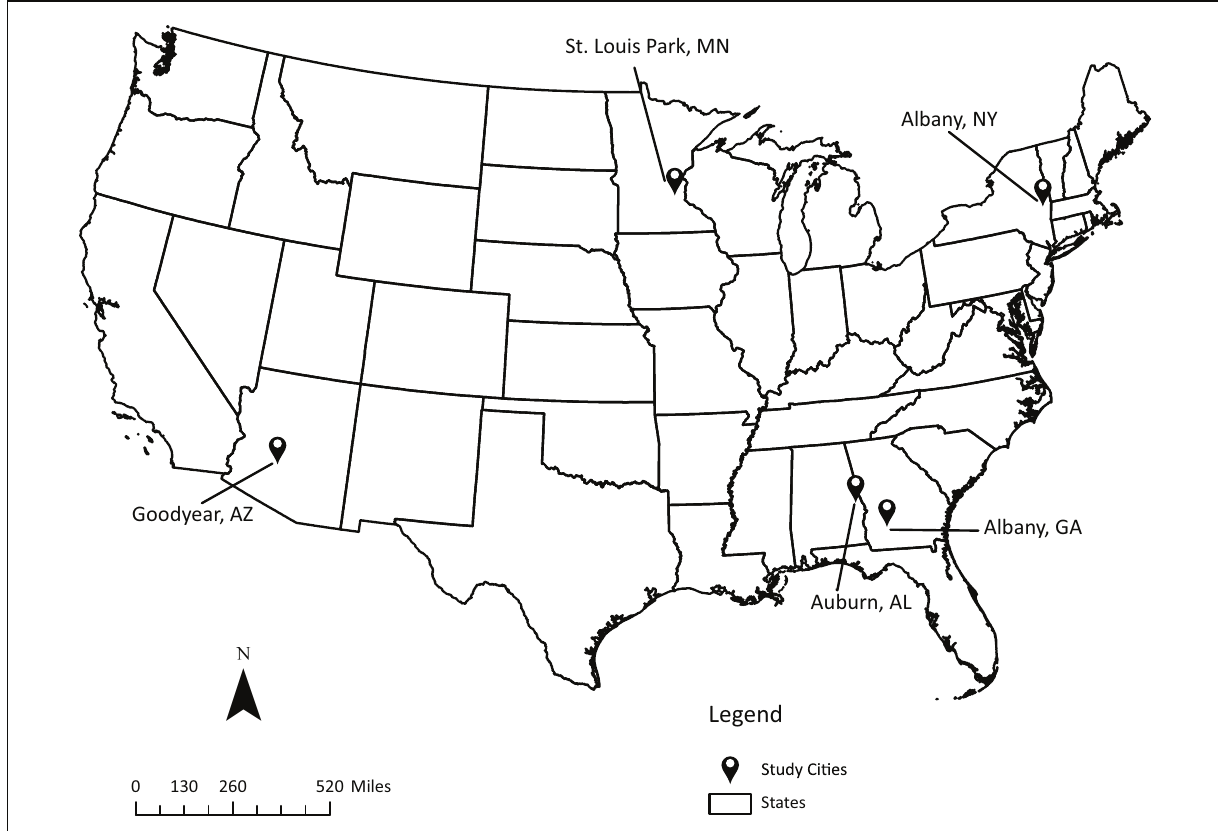
Figure 1. Location of the study cities in contiguous